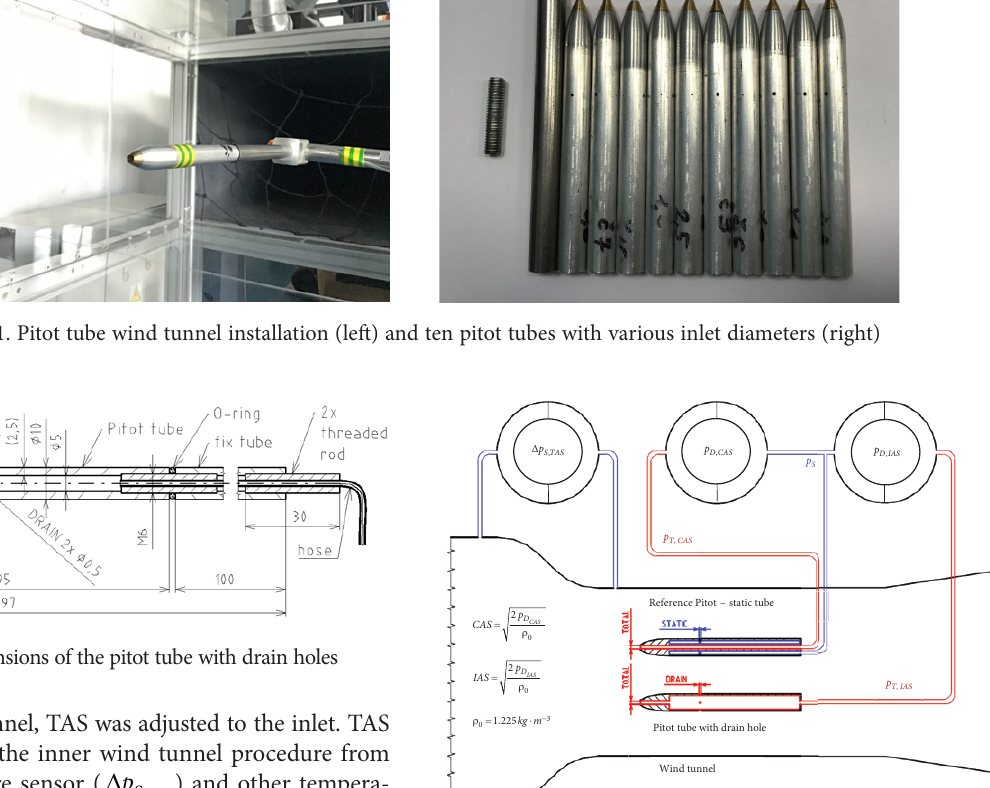
Figure 2. Dimensions of the pitot tube with drain holes